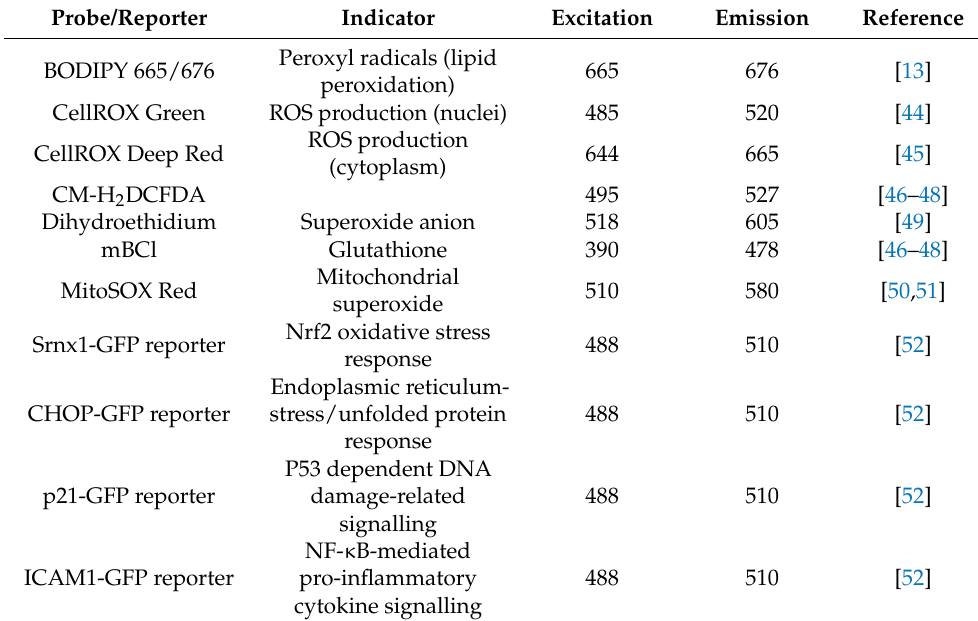
Table 2. Probes and reporters used in HCS assays for the detection of oxidative